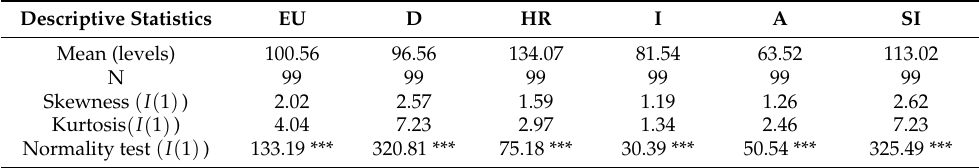
Table A4. Descriptive statistics of food and beverages price indices (base 2015), data vector 2012–2020.